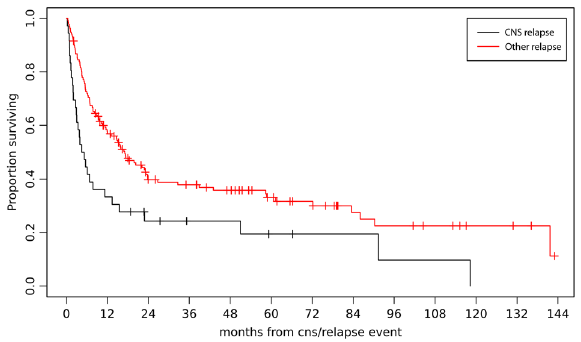
Fig. 4 Overall survival of patients with CNS relapse vs. other relapse.